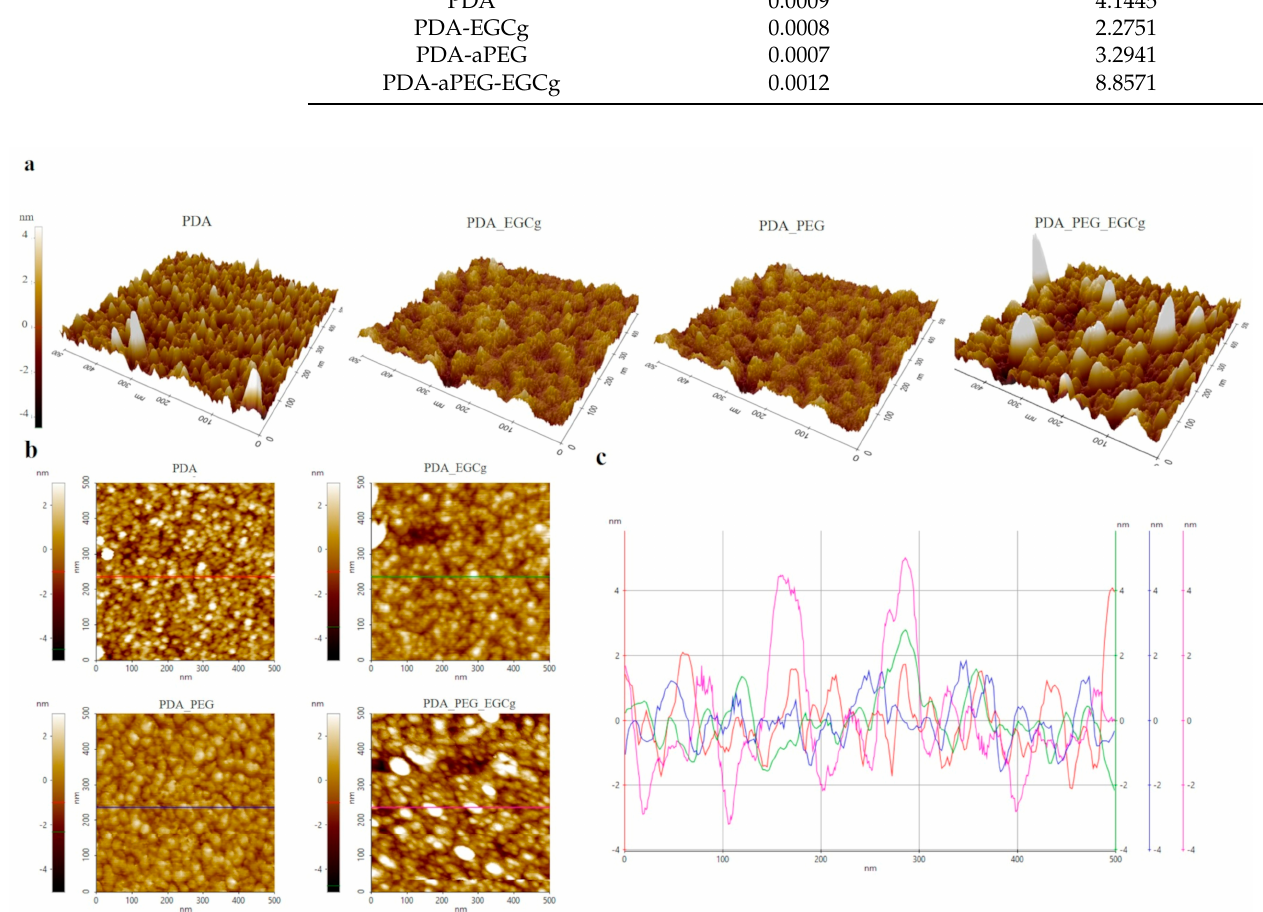
Figure 4. AFM analysis of mica coated with PDA, PDA-EGCg, PDA-aPEG, and PDA-aPEG-EGCg. ( a ) 3D images of 5 × 5 µm areas, ( b ) top view of 5 × 5 µm areas, and ( c ) line scan showing height profile.